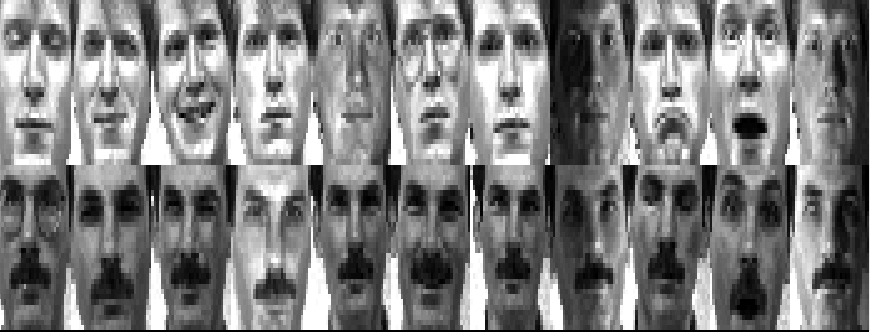
Figure 1. Samples from the Yale face